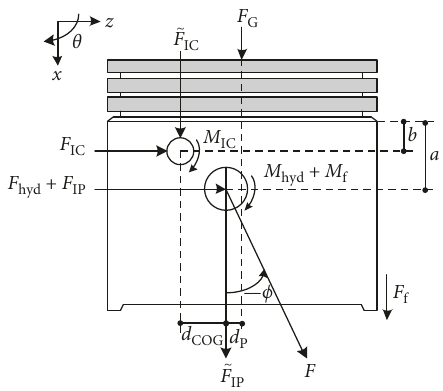
Figure 21: The force of the piston in the cylinder